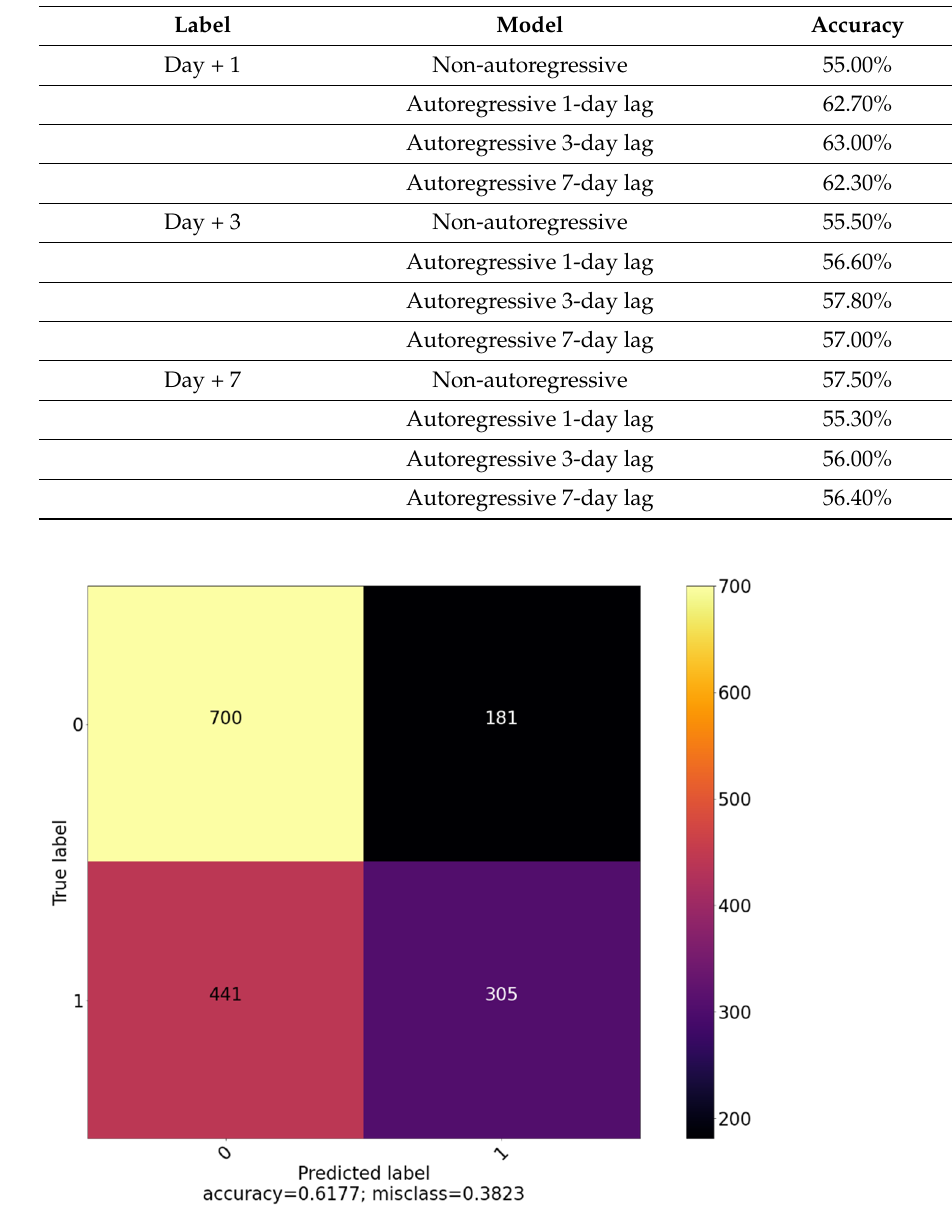
Figure 9. Confusion matrix for an autoregressive Neural Network model showing bias toward the 0 (reactive) class.